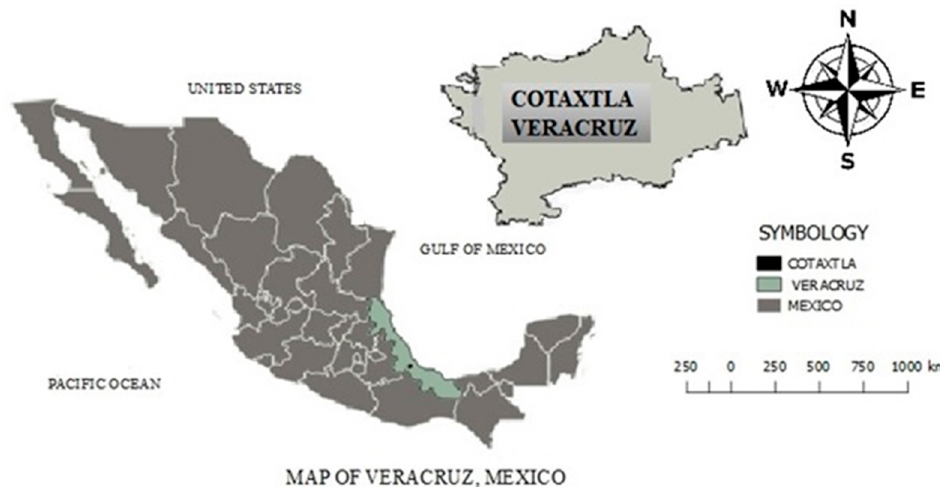
Figure 1. Location of the papaya producing area in the town of Cotaxtla, Veracruz Mexico.